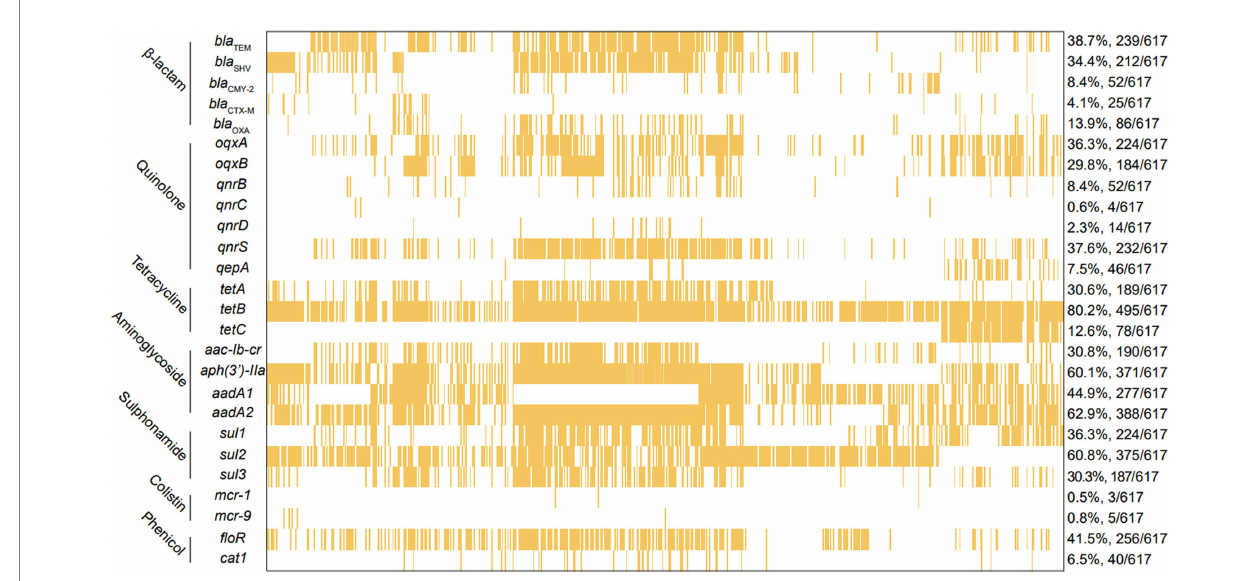
FIGURE 4 The analysis of ARGs among 617 Salmonella islolates from food animals in China. The yellow squares represent positivity for ARGs.